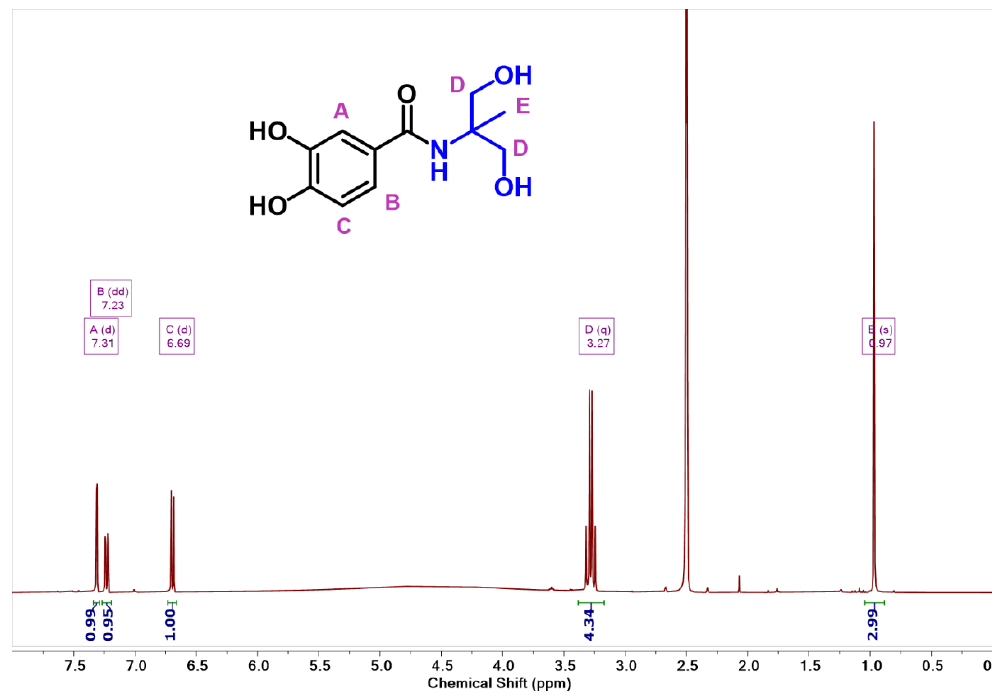
Figure 1. The 1 H-NMR of functionalized catechol (Cat-Fun) in deuterated DMSO.